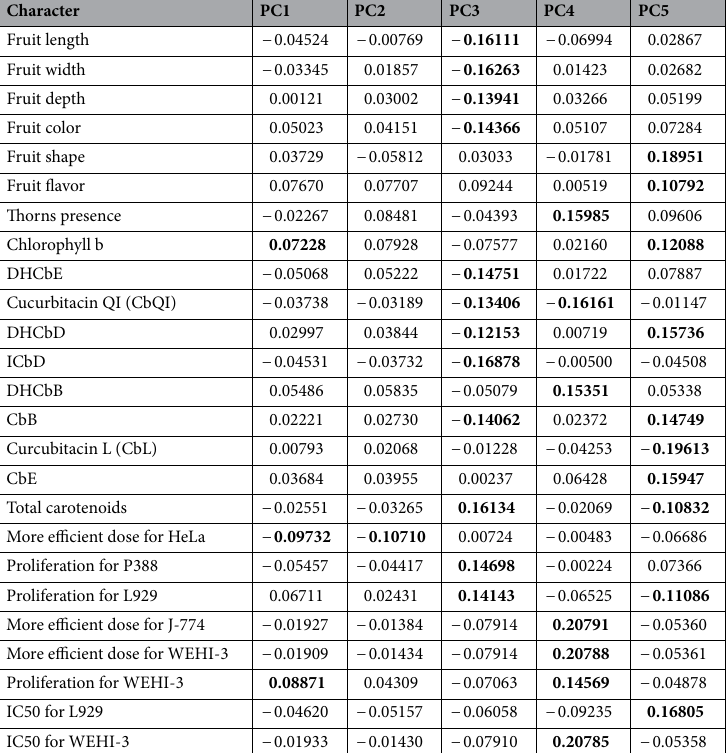
Table 5. Characteristic vectors of the analysis of 229 morphological, biochemical, genetic, and biological activity variables of fruits from ten Sechium spp. genotypes. The values in bold are those that were statistically the most significant because of their principal